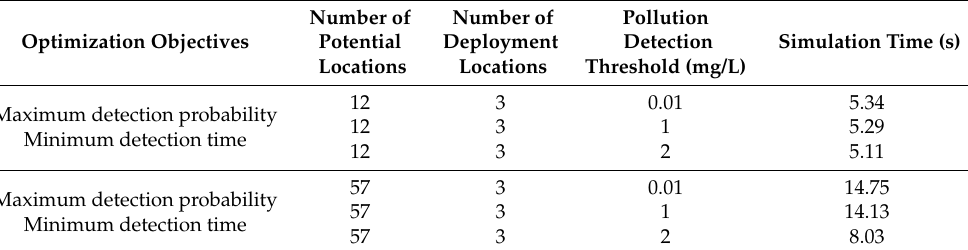
Table 11. Computational time for different